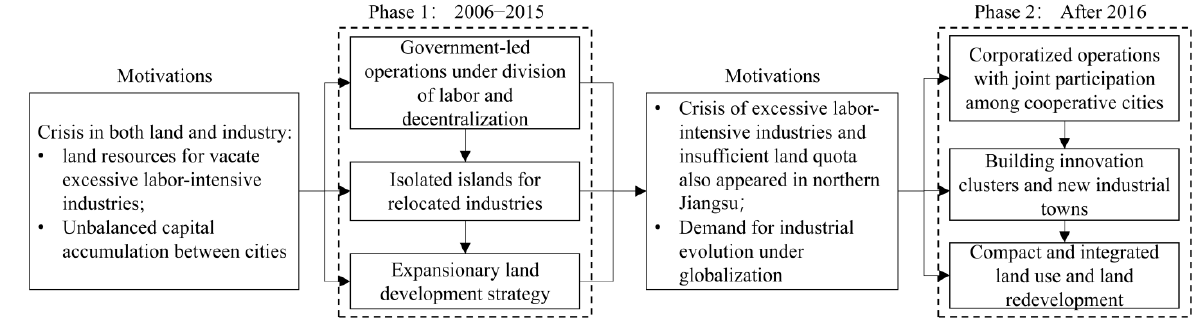
Figure 6. Evolution of multi-dimensional characteristics of The North–South Intercity Co-construction Parks of Jiangsu Province.